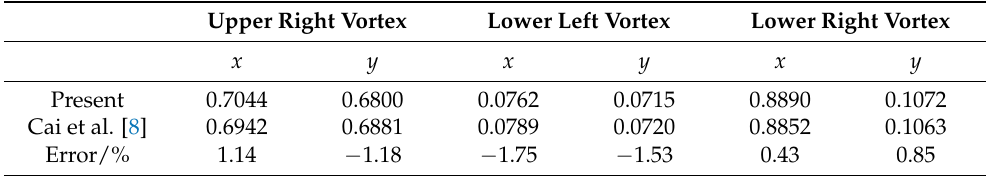
Figure 2. Vorticity contours and streamlines at r = 0.2, Re = 1000. ( a ) Vorticity (Present) ( b ) Vorticity (Cai et al. [8]) ( c ) Streamlines (Present) ( d ) Streamlines (Cai et al. [8]). Table 1. Comparison of vortice center coordinates with the moving immersed boundary method (at r = 0.2, Re =